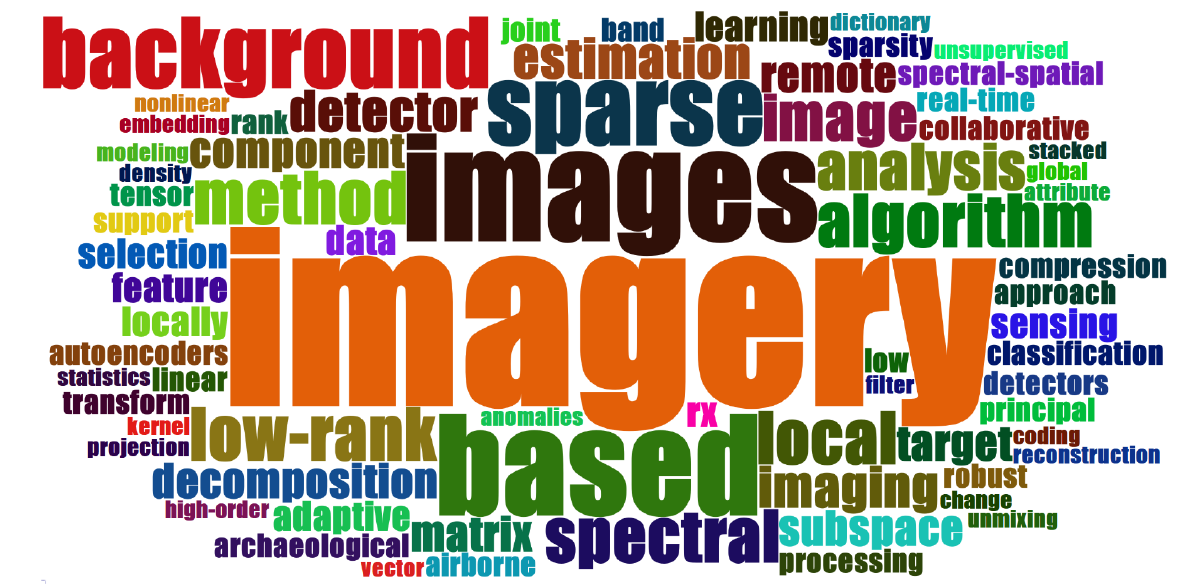
Figure 5. Word cloud generated from the most frequent keywords found in the titles of the analyzed documents. The size of the word is proportional to its frequency. The figure was created using the bibliometrix R-package [23] .